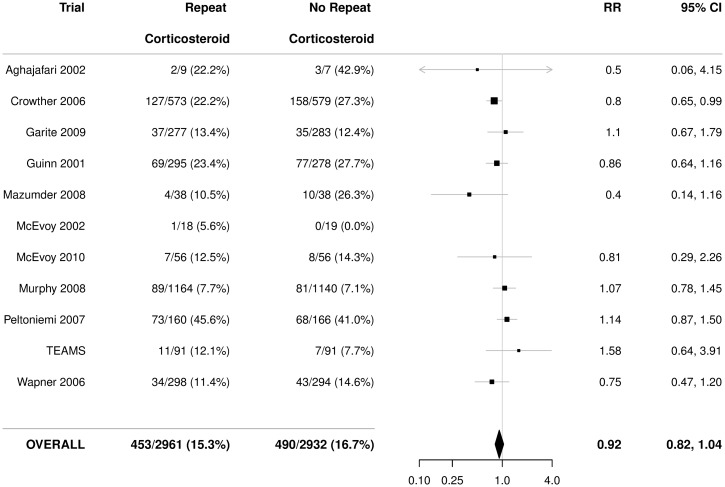
Primary outcome for the infant: Serious outcome.Serious outcome is defined as any death (fetal, neonatal, infant, or child), severe respiratory disease as defined by the trialists, grade 3 or 4 IVH, CLD (oxygen dependent at 36 weeks postmenstrual age), definite NEC, stage 3 or worse ROP in the better eye, or cystic PVL. Figures are numbers (percentages) with RR and 95% CI as treatment effect. p-value for heterogeneity = 0.33. CI, confidence interval; CLD, chronic lung disease; IVH, intraventricular haemorrhage; NEC, necrotising enterocolitis; PVL, periventricular leucomalacia; ROP, retinopathy of prematurity; RR, relative risk; TEAMS, Trial of the Effects of Antenatal Multiple courses of Steroids versus a single course.